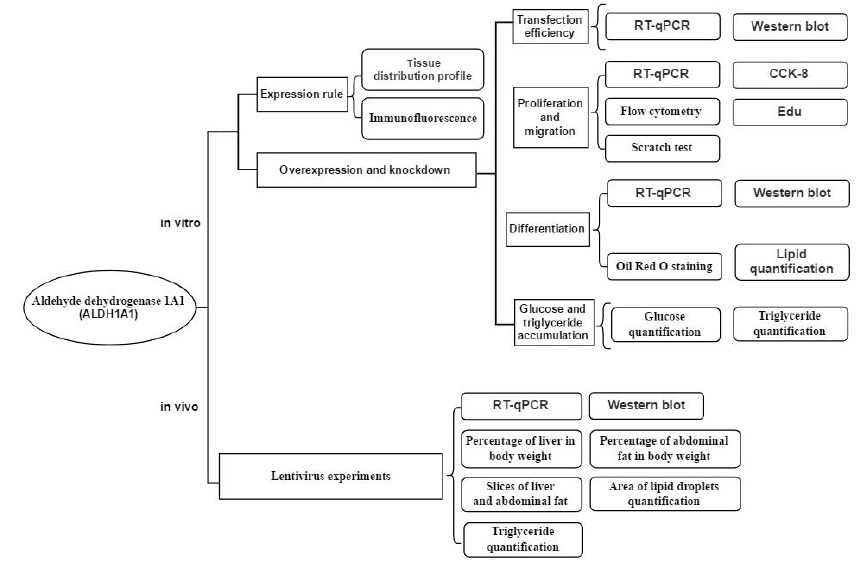
Figure 1. The workflow of the experiments on aldehyde dehydrogenase 1A1 ( ALDH1A1 ). The experimental flow diagram for the ALDH1A1 experiments in vitro and in